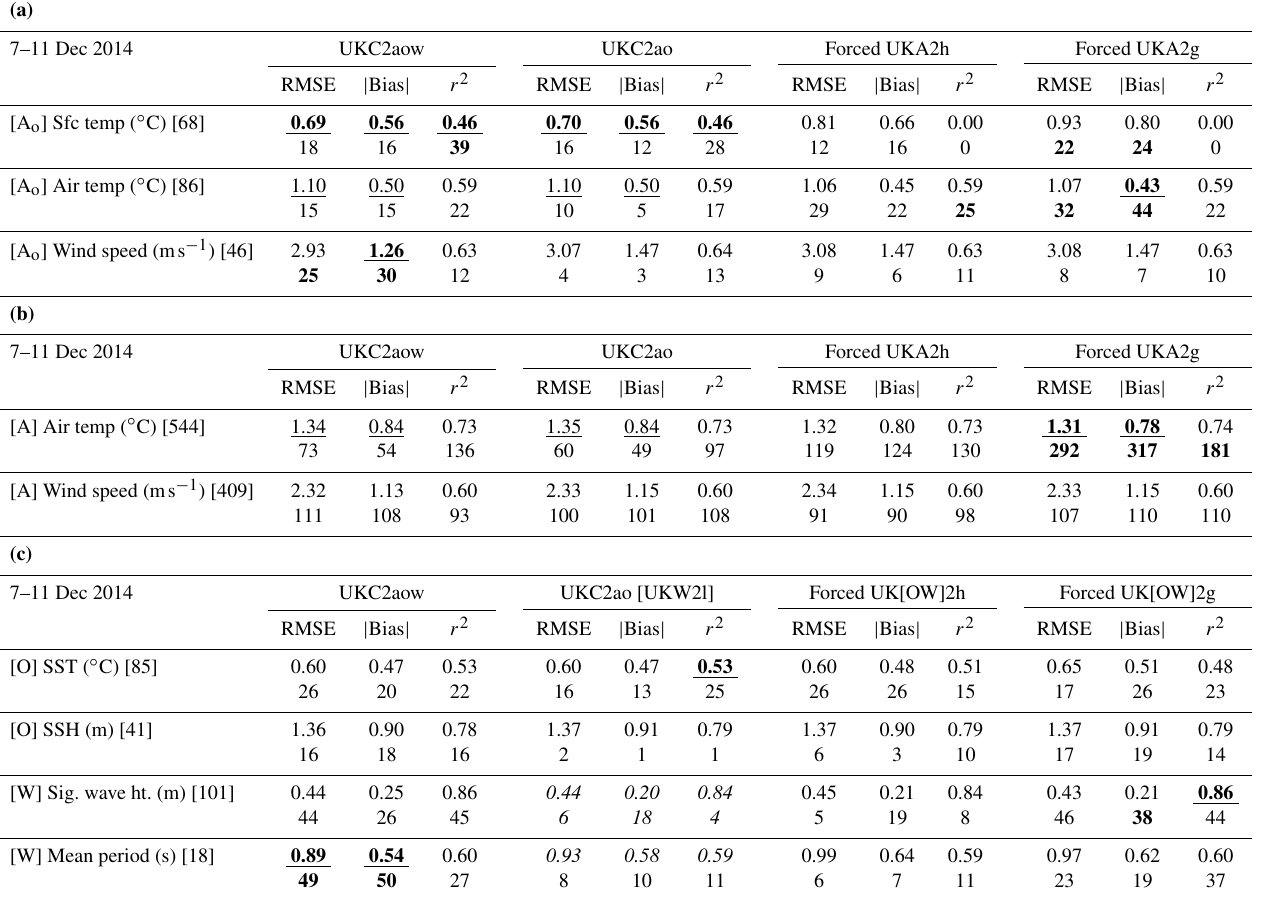
Table 7. Summary RMSE, bias and r2 correlation coefficient statistics for the 7–11 December 2014 case study. Average statistics are computed from a comparison of model output against in situ observations of (a) atmosphere [A o ] model variables over sea grid cells only, (b) all atmosphere [A] model variables, and (c) ocean [O] and wave [W] model variables. The relevant forced configuration with high-resolution forcing UKW2h, UKO2h and UKA2h are treated as the reference control model. Results showing a statistically significant difference from the reference according to a t test at the 95% confidence level are underlined. Those also showing an improvement against the reference are also in bold. Also listed for each variable under the horizontal lines for each metric is the number of sites for which the model configuration provided the best statistic relative to the other model configurations tested for this case. The configuration with the highest number of sites listed is highlighted in bold. Numbers in square brackets show the number of observation locations assessed for each